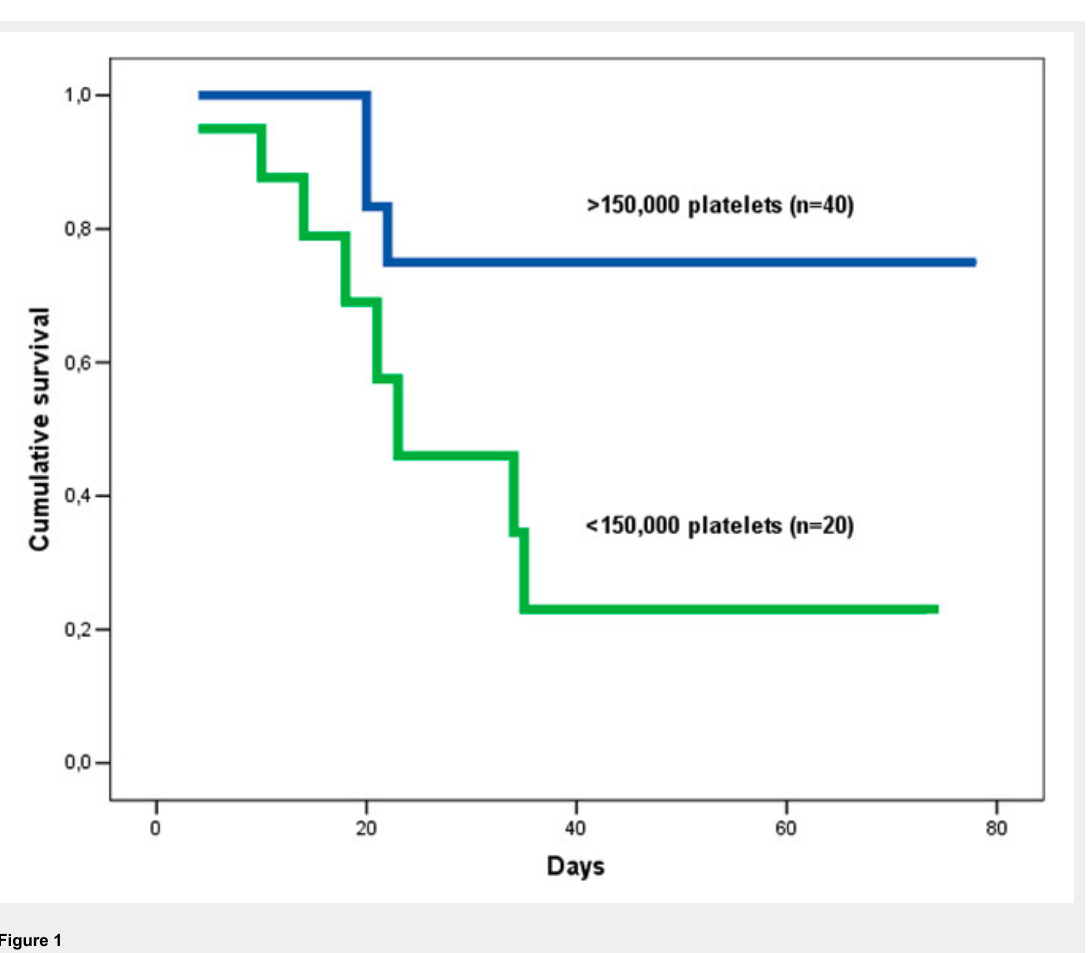
Figure 1 Cumulative survival rate of H1N1 influenza respiratory failure patients with